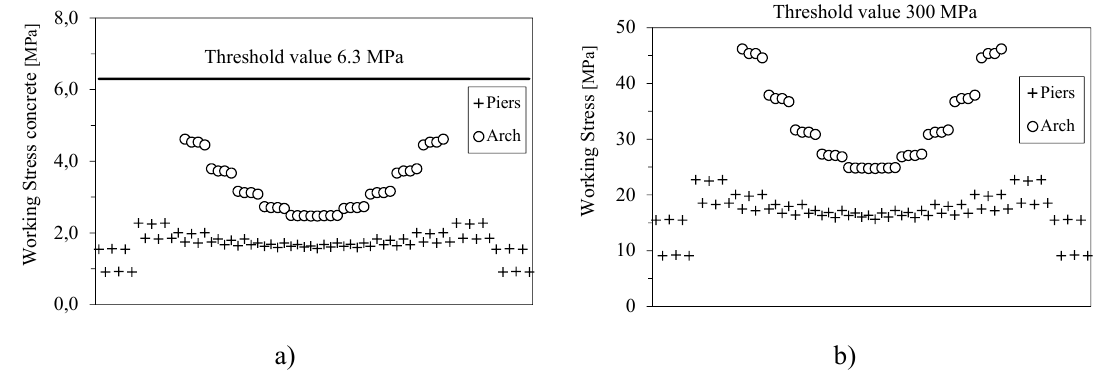
Figure 7. Structural verifications of compression stresses in the arch and the piers: a) compressed concrete; b) ă compressed steel reinforcement.